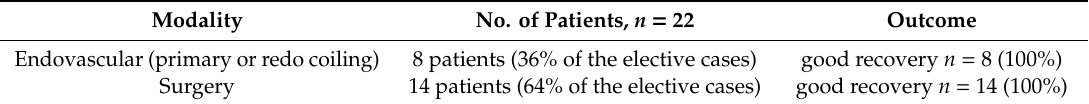
Table 5. Elective treatments in ACoAA patients; Glasgow Outcome Score after three months.